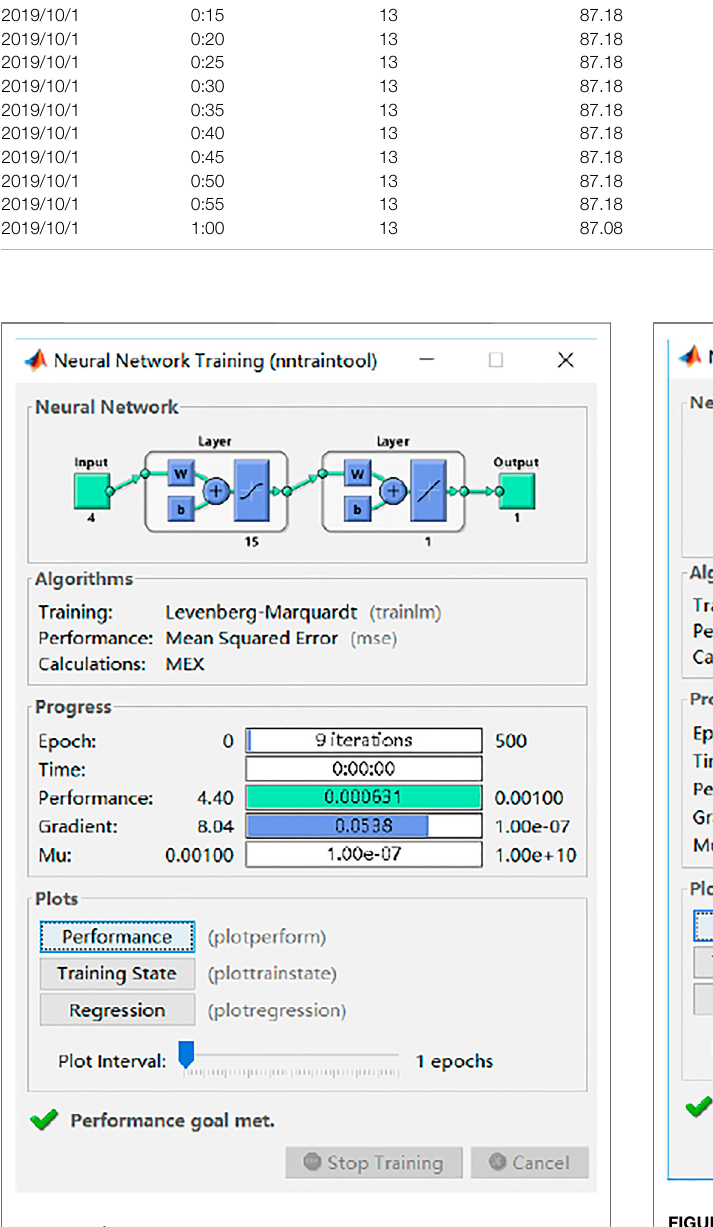
FIGURE 4 | BP neural network simulation training diagram.